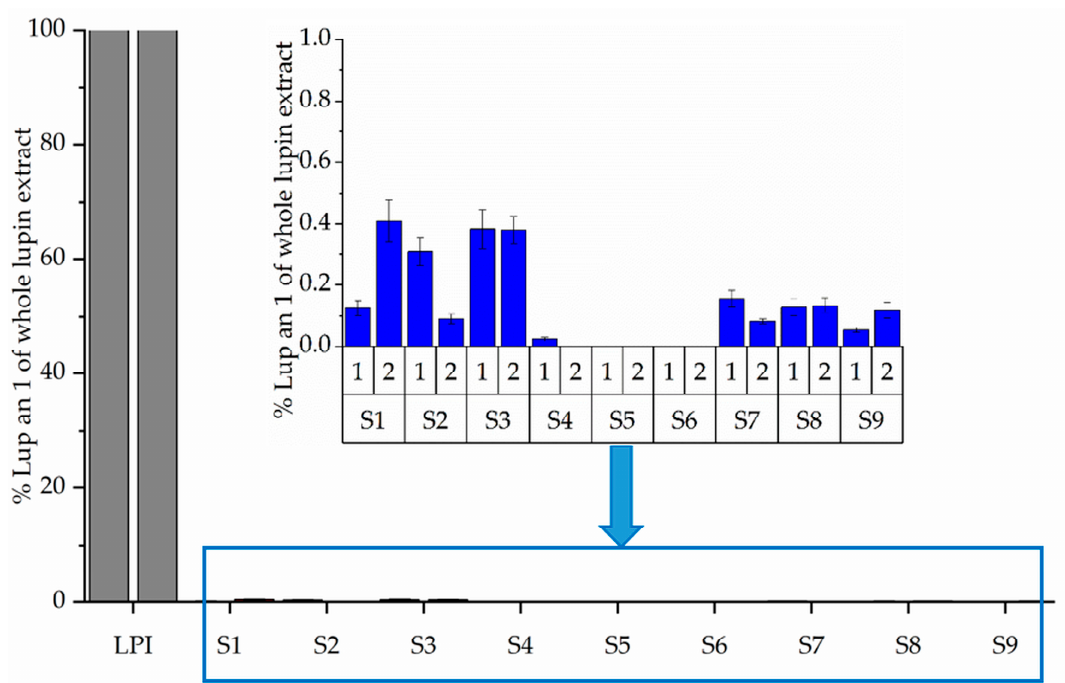
Figure 3. Determination of Lup an 1 with specific monoclonal antibodies (Izimab Lup an 1-1 and Izimab Lup an 1-2) of unfermented LPI and fermented LPI hydrolysates using Bead-Assay. Results are shown as mean ± standard derivation of each duplicate (1 and 2). Each Bead-Assay was performed in triplicate.